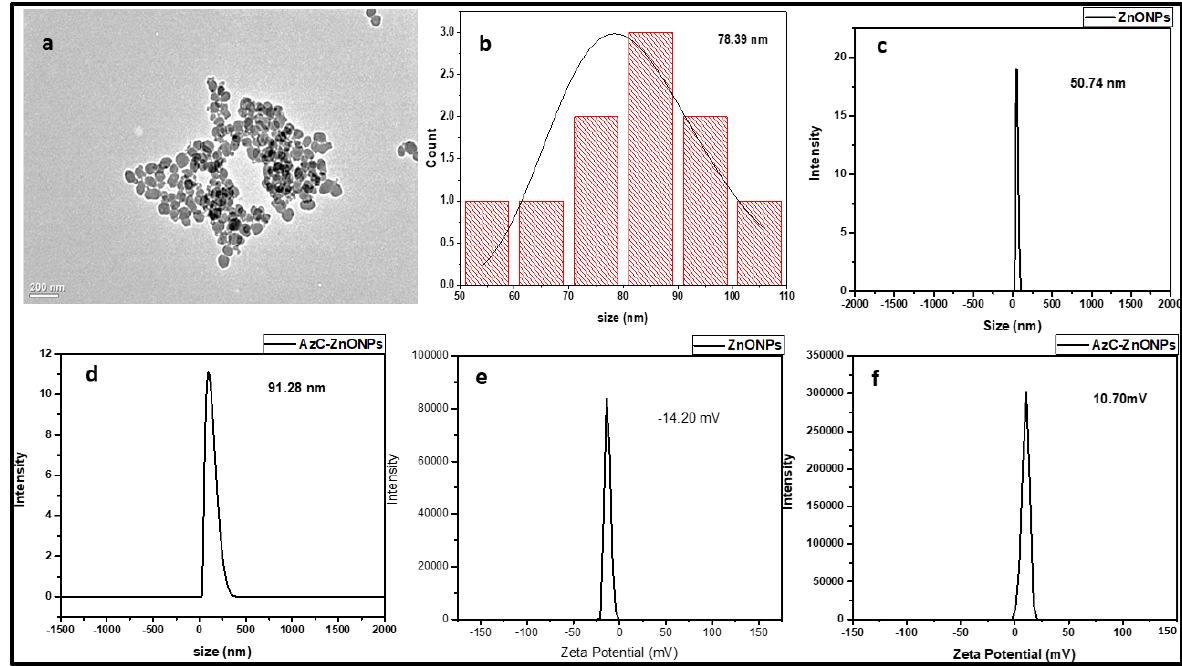
Figure 1. Characterization of AzC ‐ ZnONPs: ( a , b )TEM Image and its corresponding Histogram; DLS Plot of ( c ) ZnONPs, ( d ) AzC ‐ ZnONPs; Zeta potential of ( e ) ZnONPs and ( f ) AzC ‐ ZnONPs. Plot of ( c ) ZnONPs, ( d ) AzC-ZnONPs; Zeta potential of ( e ) ZnONPs and ( f )